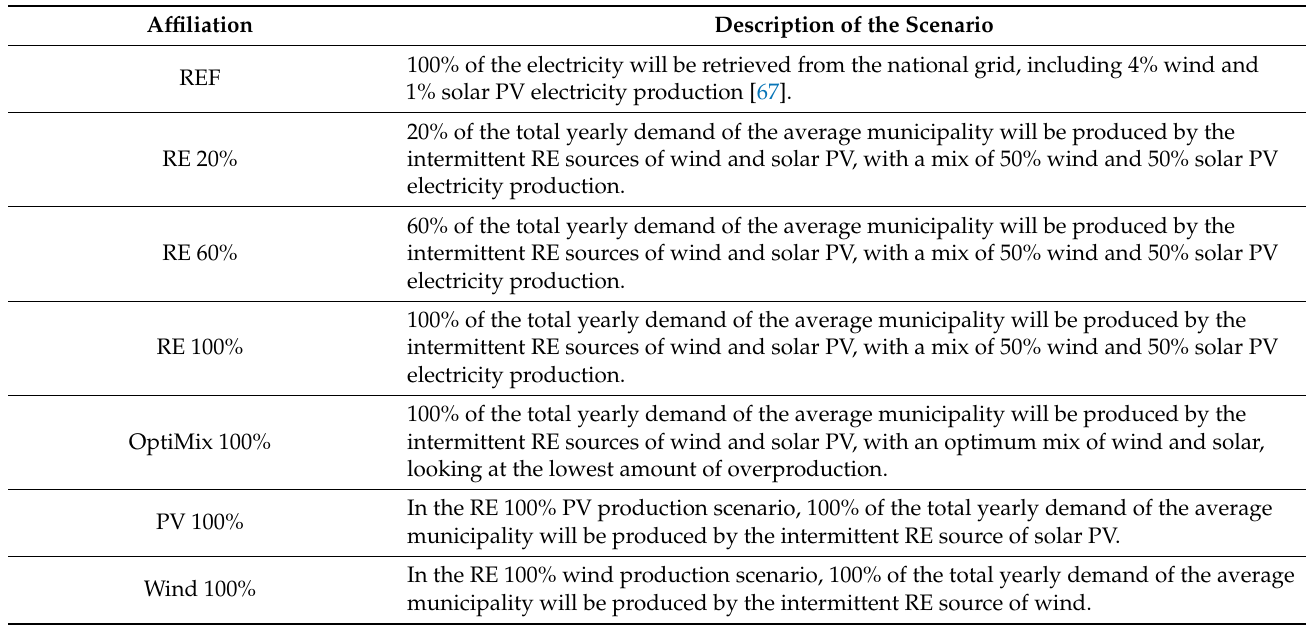
Table A8. Renewable integration scenarios.